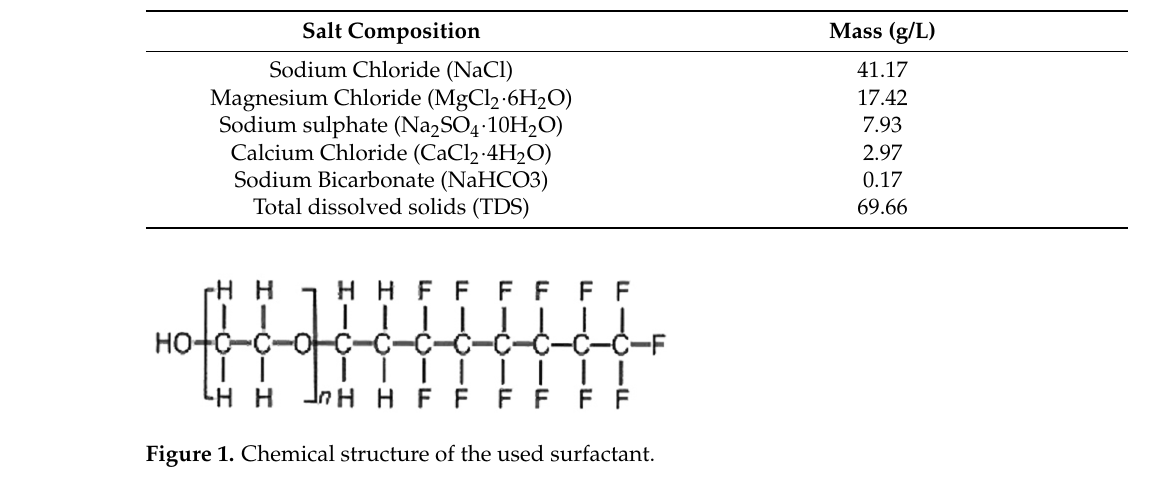
Table 2. Synthetic brine composition.